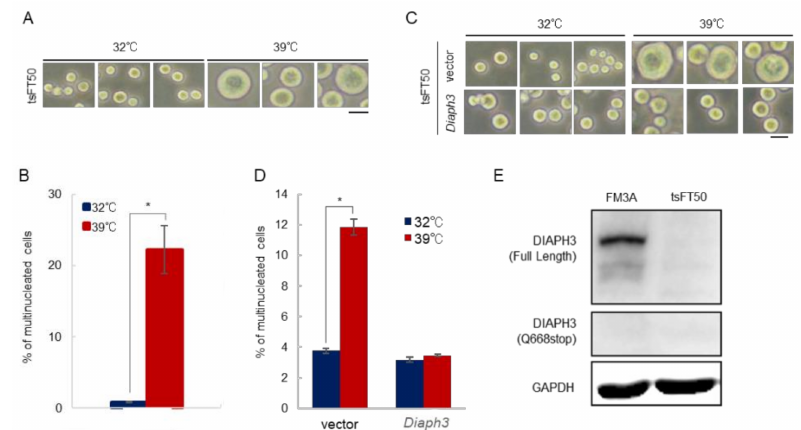
Figure 2. Diaph3 is not expressed at the protein level in tsFT50 cells. ( A ) Cell images: The tsFT50 cells were cultured at 32 or 39 ◦ C under 5% CO 2 for 96 h. The scale bar indicates 50 µ m. ( B ) The tsFT50 cells were incubated at 32 and 39 ◦ C for 24 h and were then stained with DAPI. More than 300 cells were measured, and the percentage of the multinucleated cells was calculated; (error bars: ± SEM); * p < 0.01 (Student’s t-test); 32 vs. 39 ◦ C. ( C ) Control tsFT50 cells (vector) and Diaph3 -expressing tsFT50 cells ( Diaph3 ) were cultured at 32 or 39 ◦ C under 5% CO 2 for 96 h. The scale bar indicates 50 µ m. ( D ) Control tsFT50 cells (vector) and Diaph3 -expressing tsFT50 cells ( Diaph3 ) were cultured at 32 and 39 ◦ C for 24 h. The percentage of multinucleated cells were calculated as described in ( B ); (error bars: ± SEM); * p < 0.01 (Student’s t-test); 32 vs. 39 ◦ C. ( E ) Expression of Diaph3 at 32 ◦ C in FM3A and tsFT50 cells was confirmed by Western blotting. Anti-DIAPH3 antibodies recognizing residues 554–662 of DIAPH3 were used; GAPDH was used as a loading